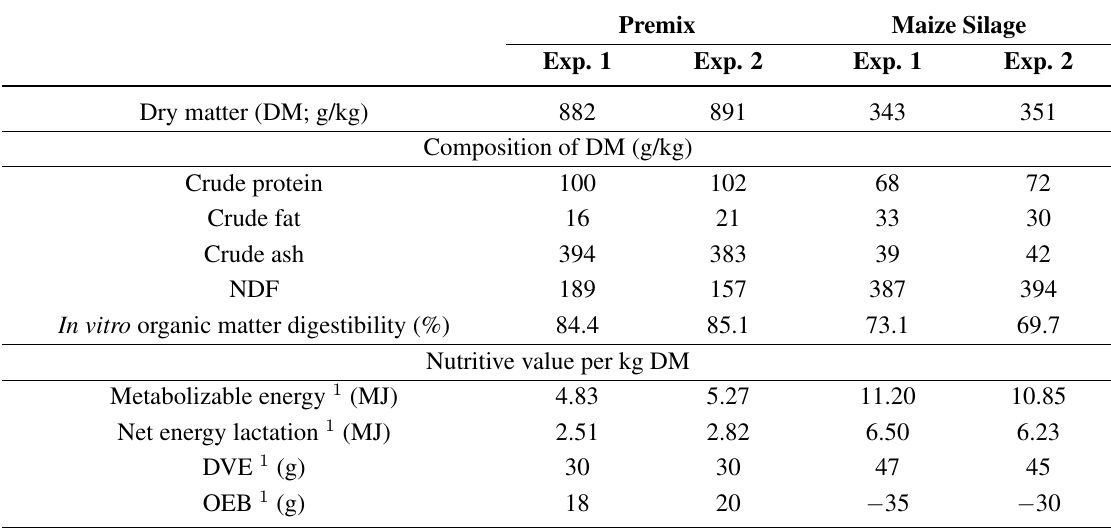
Table 1. Chemical composition and nutritive value of the feeds. Premix Maize